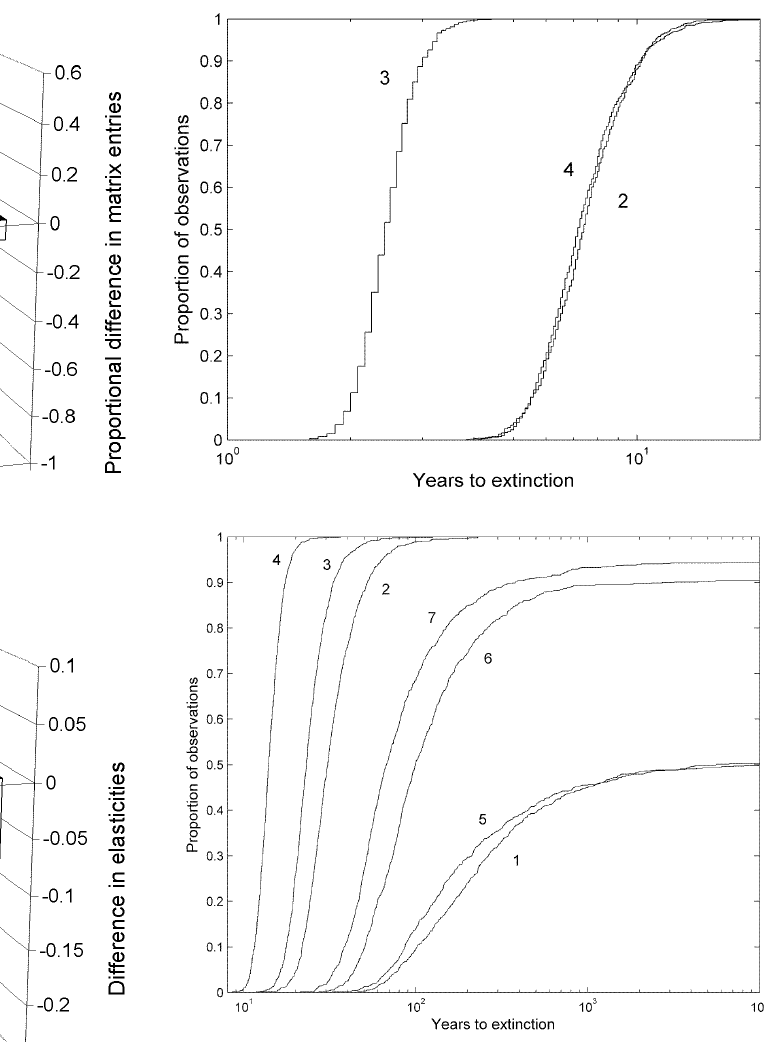
Figure 4. Empirical cumulative distributions of years to tributary extinction (above) for the three tributary scenarios and system extinction (below) for the seven scenarios. Scenario identifiers are in Table 3. Distributions were based on 1000 parametric bootstrap samples for each scenario.